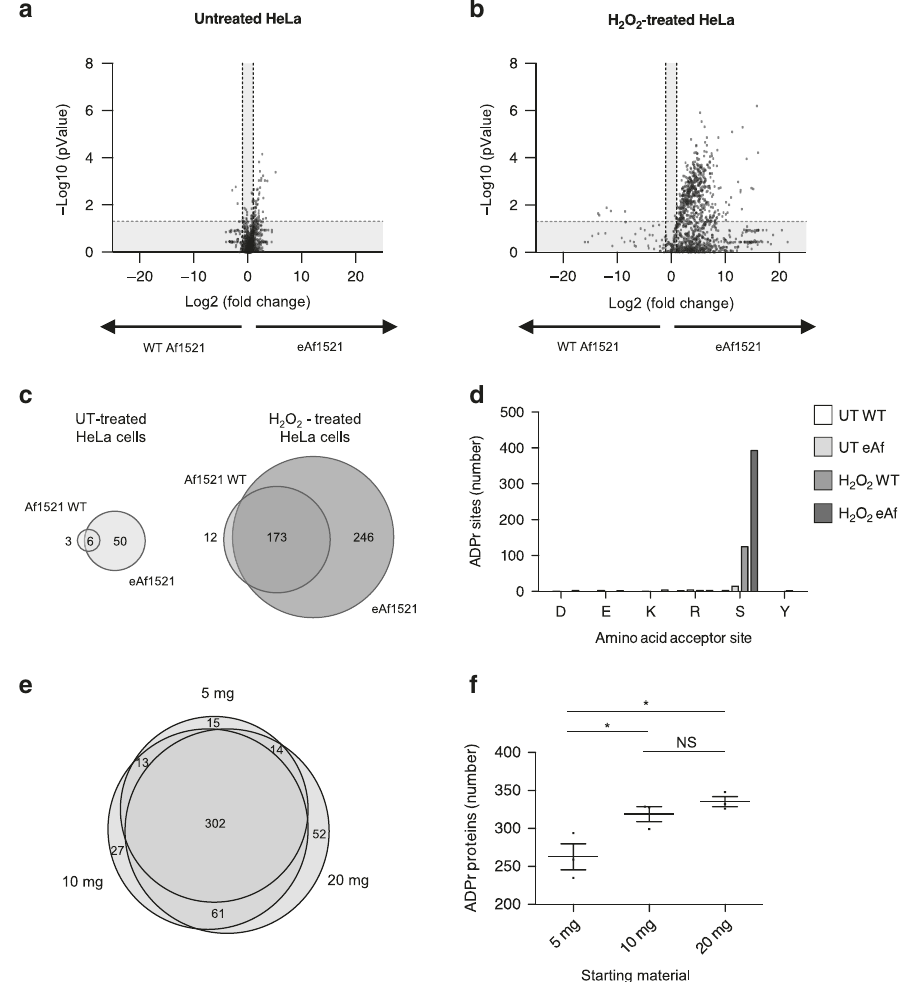
Fig. 2 Stronger enrichment of ADP-ribosylome by eAf1521 compared to WT Af1521. a , b Volcano plots comparing ADP-ribosylated peptides enriched from untreated and H 2 O 2 -treated HeLa cells, with either WT Af1521 or eAf1521. The statistical analysis and p value calculation was performed with two- tailed Student ’ s t test, the black lines represent foldchange > 2 and p value < 0.05. c Venn diagrams displaying the overlap of ADP-ribosylated protein groups enriched from untreated (left panel) or H 2 O 2 -treated HeLa cells (right panel), with either WT Af1521 or eAf1521. d Distribution of ADPr on different amino acid acceptor sites (D, E, K, R, S, and Y). Only EThcD data with a site localization score of 95% were considered. e Venn diagram representing the overlap of ADP-ribosylated protein groups enriched with eAf1521 using different amounts of starting material (5, 10, and 20 mg). f Scatter plot comparing the number of ADP-ribosylated protein groups identi fi ed via eAf1521 enrichment using different amounts of starting material (5, 10, and 20 mg). Data are presented as mean ± SEM ( n = 3 biochemical independent samples). The statistical analysis and p value calculation was performed with